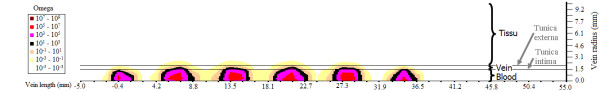
Isodamage distribution inside tissues power: 15 W, pulse: 2s, delay: 2s, pull-back distance: 5 mm; vein diameter: 3 mm, λ = 980 nm).